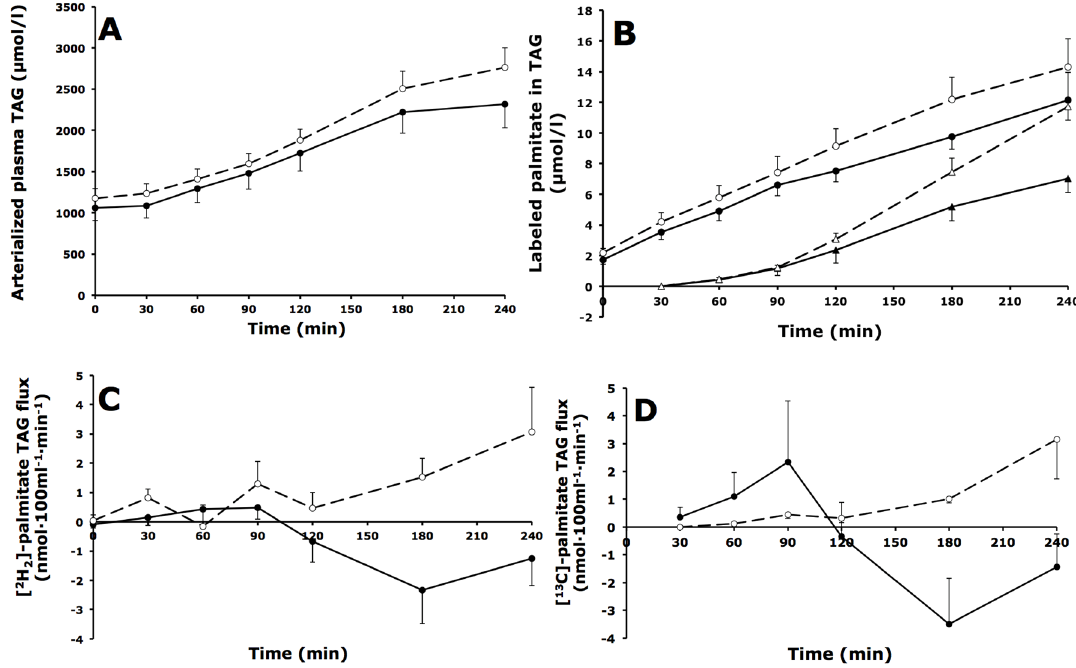
Figure 3. Fasting and postprandial whole-body triacylglycerol (TAG) metabolism. ( A ) Arterial plasma TAG concentrations; ( B ) [ 2 H 2 ]- and [U- 13 C]-palmitate concentrations in the plasma TAG fraction; ( C ) Net flux of [ 2 H 2 ]-palmitate TAG; ( D ) Net flux of [U- 13 C]-palmitate TAG across forearm muscle during fasting ( t = 0) and after consumption of a high-fat mixed-meal in IFG (black symbols, solid lines) and IGT subjects (open symbols, dashed lines). Circles represent [ 2 H 2 ]-palmitate TAG; triangles represent [U- 13 C]-palmitate TAG. Values are mean ˘